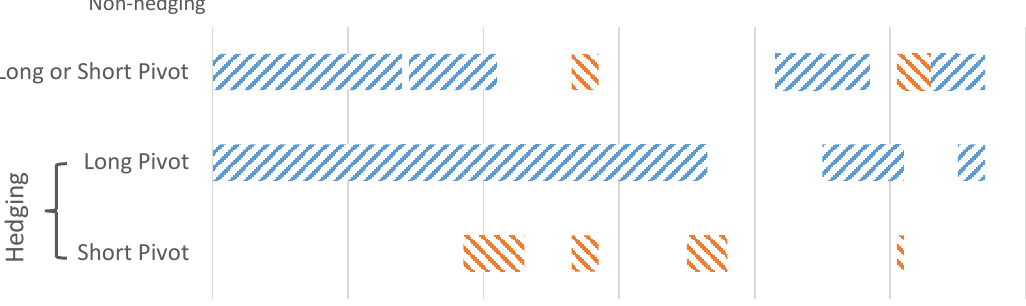
Figure 5. Example of long and short positions for the three systems during a sample week